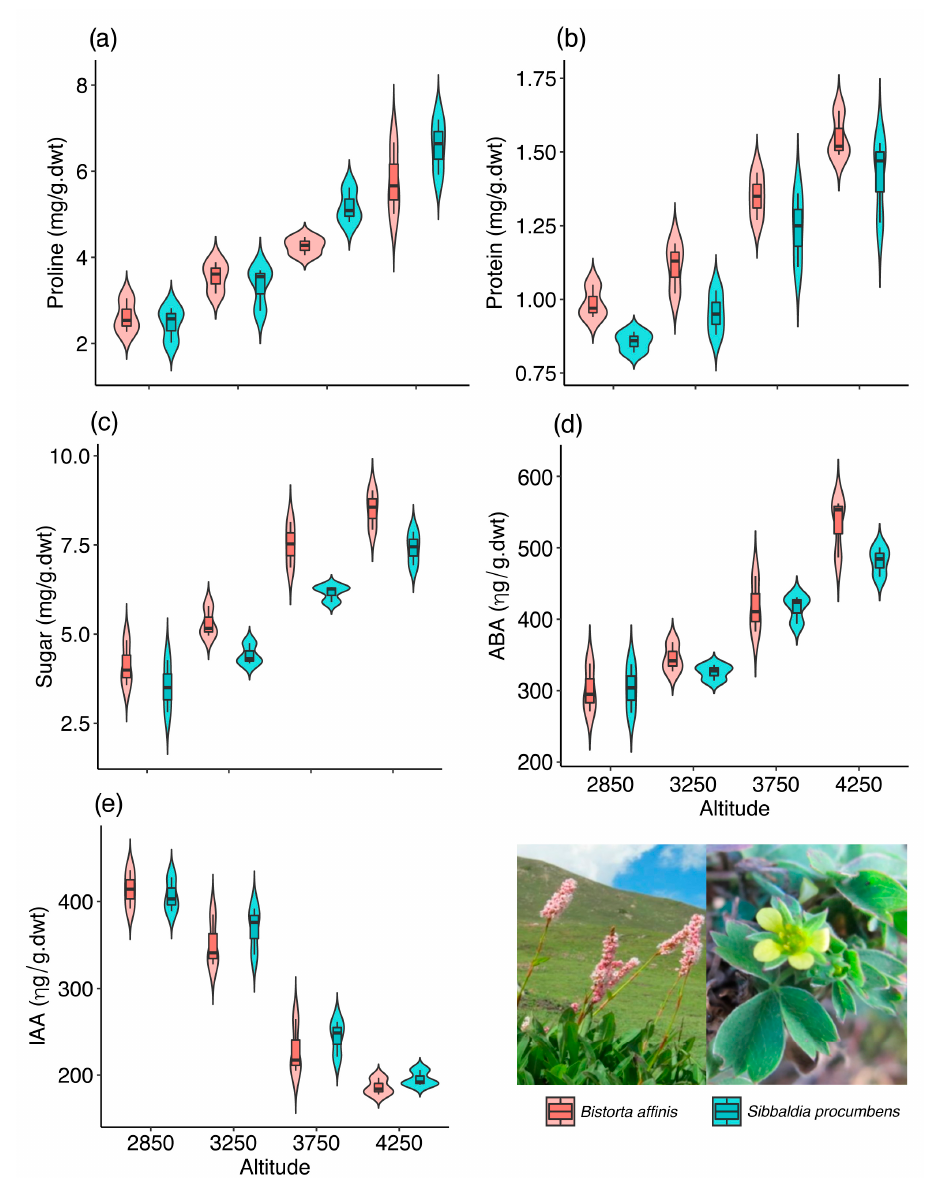
Means with similar letters in each column are non-significantly different according to least significant differences (LSD) (see Table 1).